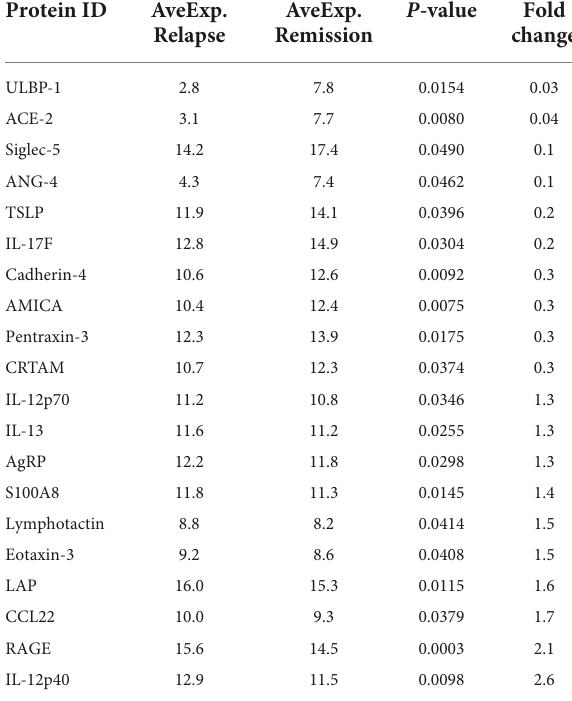
TABLE 3 The information of top 20 differentially expressed cytokines TABLE 2 Baseline characteristics of non-relapse and relapse minimal between non-relapse group and relapse group in Raybiotech 440 change disease (MCD) patients for the array results validation. cytokine antibody Characteristic Non-relapse MCD Relapse MCD group ( N = 29) group ( N = 35)